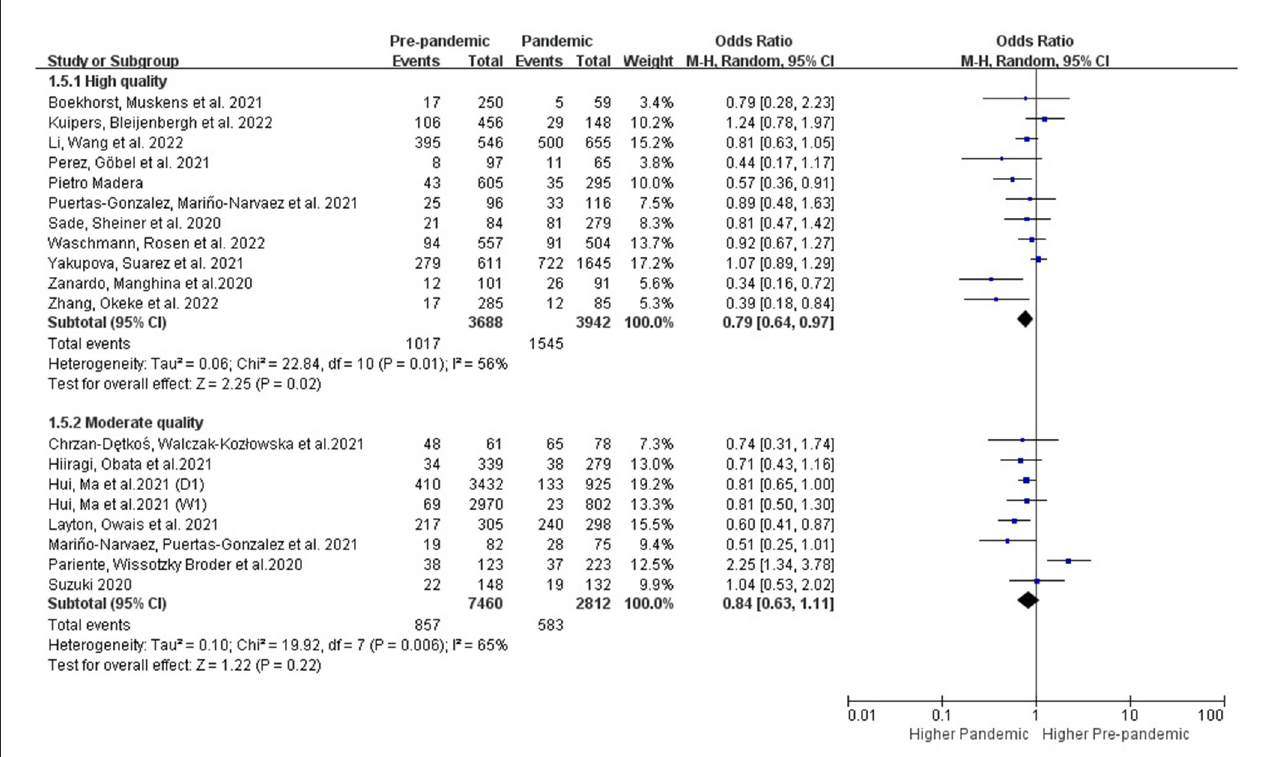
FIGURE5 Subgroup analysis comparing the prevalence of PPDS before and during the COVID-19 pandemic according to study quality.